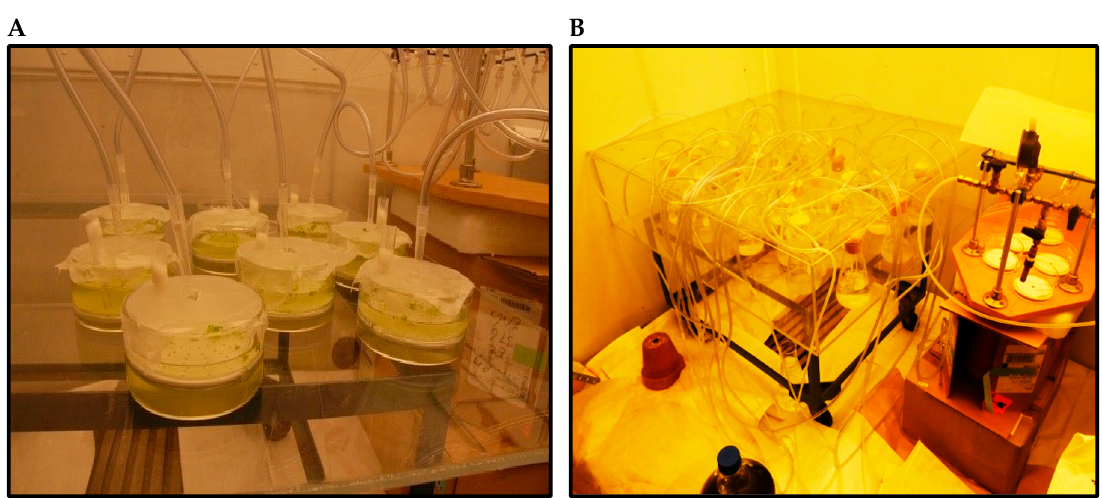
Figure 1. The experimental setup for duckweed in the 300 mL glass bowls ( A ) and microalgae in 250 mL Erlenmeyer flasks ( B ) grown with aeration through plastic discs with 2 mm pores and a flow control manifold ( A , B ) in a walk-in chamber. Photo by Kozlova T.A.